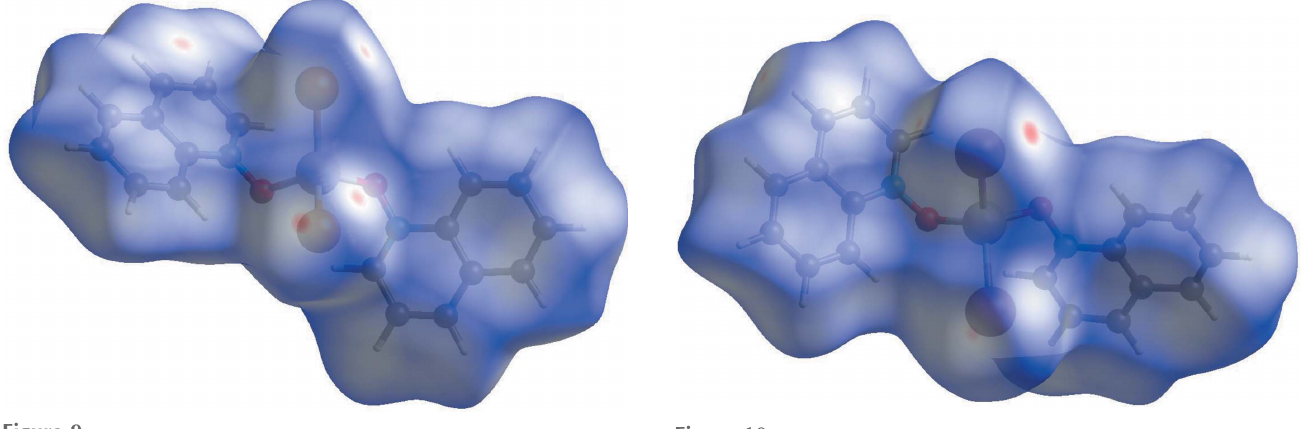
Figure 10 Hirshfeld surface for ( III ) mapped over d norm .